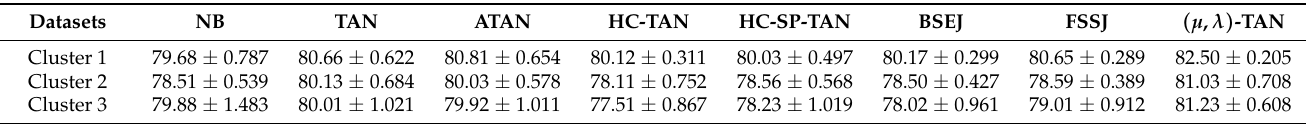
Table 4. Performance comparison of NB, TAN, ATAN, HC-TAN, HC-SP-TAN, BSEJ, FSSJ, and ( µ , λ ) -TAN in terms of recall in the test set.